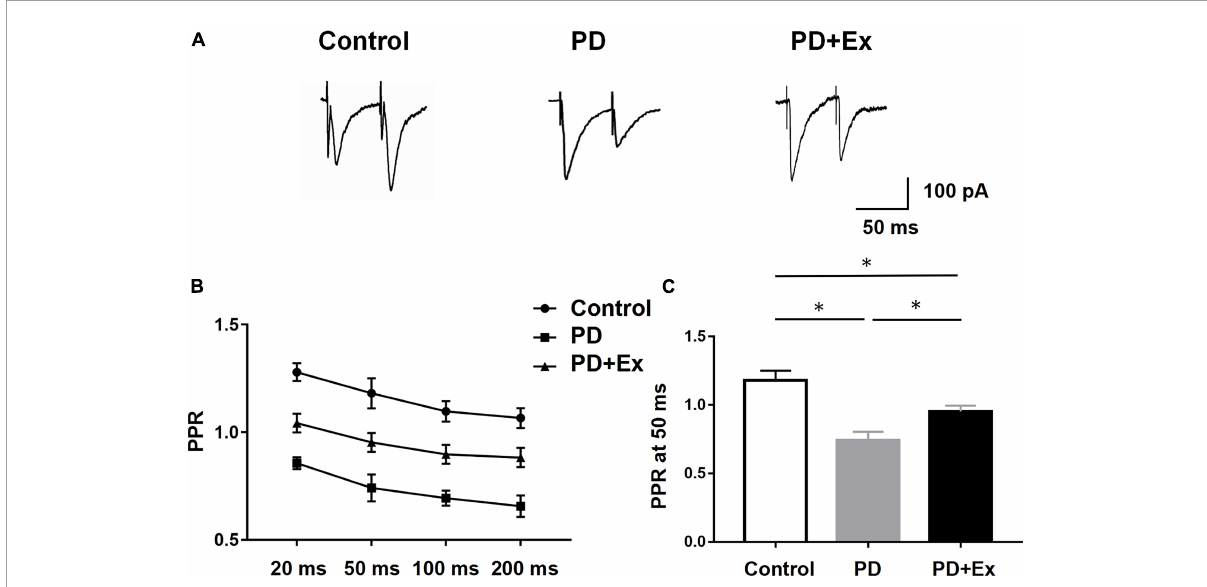
FIGURE6 Effect of exercise on D2-MSNs PPR in PD mice. (A) Representative traces of EPSCs evoked by paired-pulse stimulation at 50 inter-stimulus intervals (ISI). (B) Summary graph of PPR from MSNs (stimulation at 20, 50, 100, and 200 ms inter-stimulus intervals, two-way ANOVA, p < 0.05). (C) PPR at 50 ms interval in each group (one-way ANOVA, p < 0.05). All data are showed as mean ± SEM. ∗ p < 0.05.